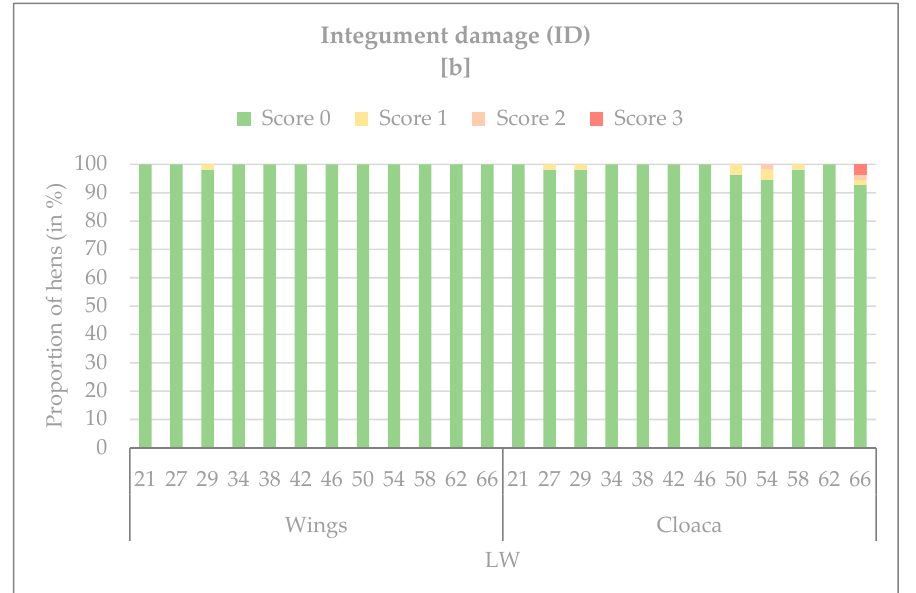
Figure 7. ( a and b ) Proportion (in %) of hens ( n = 50 (week 21); n = 55 (weeks 27–66)) with different scores (0–3) for ID at different ages (LW) for different body sections (a: back and tail; b: wings and cloaca).